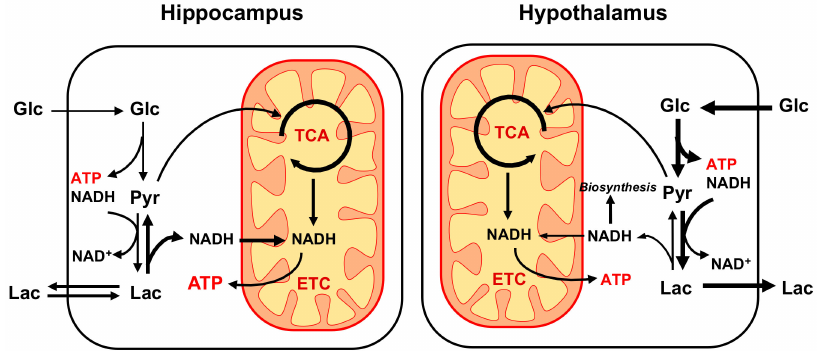
Figure 5. Schematic representation of main energy metabolic differences observed between hip- pocampus and hypothalamus using 1 H-[ 13 C]-MRS. Overall, energy production rate appears to be higher in hypothalamus (hippo: 20.5 vs. hypo: 23.7 µ mol ATP/g/min) with a distinct metabolic organization. While tricarboxylic acid (TCA) cycle is comparable between structures, suggesting similar mitochondrial NADH production and oxidation, hippocampus relies significantly less on glycolysis to produce energy. The resulting lack of cytoplasmic ATP and NADH produced in the hippocampus are likely to be compensated by blood lactate influx that can provide NADH to be oxidized by the electron transport chain (ETC) in a process involving the malate-aspartate shuttle (MAS). As a result, the glycolysis-based metabolism of hypothalamus might produce more lactate and cytoplasmic NADH that is available for biosynthetic